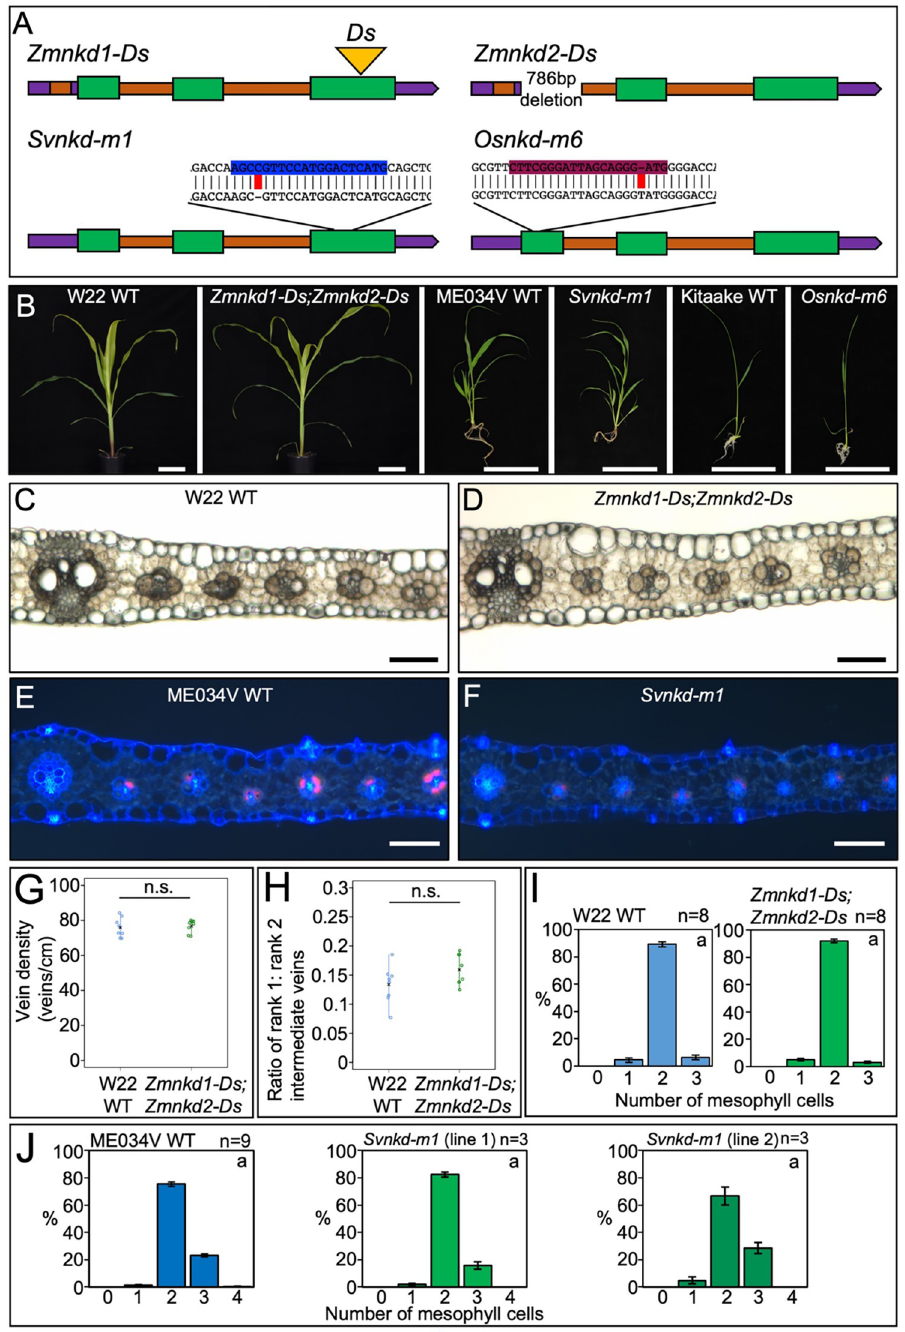
Fig 4. nkd loss of function mutations do not perturb growth in maize, rice or setaria. A) Cartoon depictions of loss of function nkd alleles in maize ( Zm ), setaria ( Sv ) and rice ( Os ). In each case, 5’ and 3’ untranslated regions are depicted in purple, introns in orange and coding regions in green. Transposon insertions are indicated by a yellow triangle. For setaria and rice, CRISPR guide sequences are indicated in blue and maroon respectively, with the sequence of the mutant allele beneath with edits highlighted in red. B) Whole plant phenotypes of maize, setaria and rice nkd mutants. Photos were taken 31 days (maize), 20 days (setaria) or 14 days (rice) after sowing. Scale bars: 10cm. C-F) Transverse sections of maize wild-type (WT) W22 (C), Zmnkd1-Ds;Zmnkd2-Ds (D), setaria WT ME034V (E) and Svnkd-m1 (F), imaged under either brightfield (maize) or UV illumination (setaria). Images were taken at the mid- point along the proximal-distal axis of either leaf 5 (maize) or leaf 4 (setaria). Scale bars: 100 μ m. G-H) Quantification of vein density (G) and the ratio of rank1:rank2 intermediate veins (H) of WT W22 (blue) and